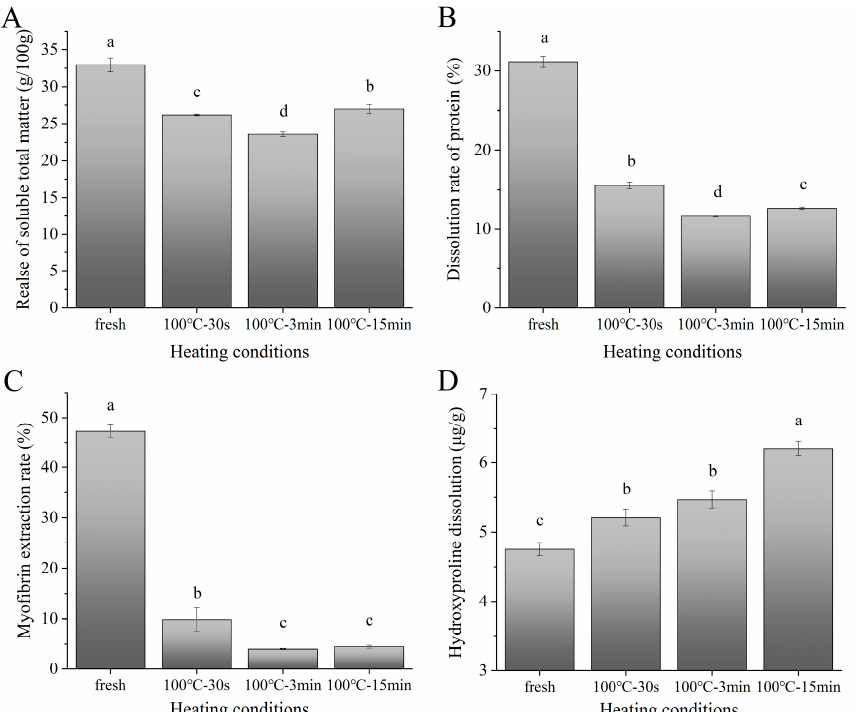
Figure 1. Changes in water-soluble matter ( A ), water-soluble protein ( B ), myofibrin extraction ( C ), and water-soluble Hyp ( D ) of SAMs after boiling. 100 °C–30 s, 30-s-boiled sample; 100 °C–3 min, 3-min-boiled sample; 100 °C–15 min, 15-min-boiled sample; values with different superscript letters indicate significant differences at the level of p < 0.05.